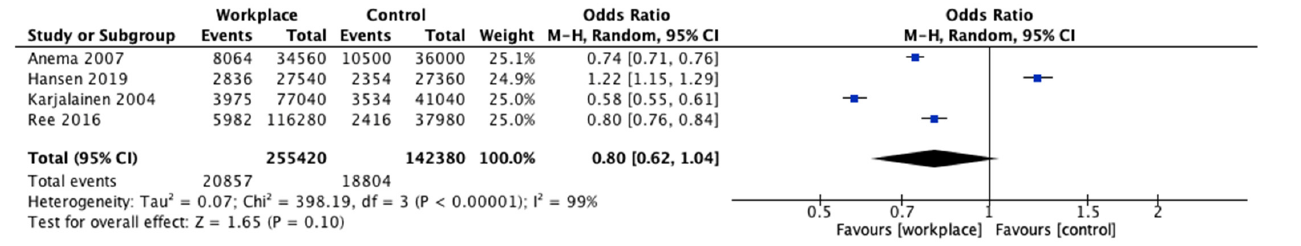
Figure 4. Days of sick leave.